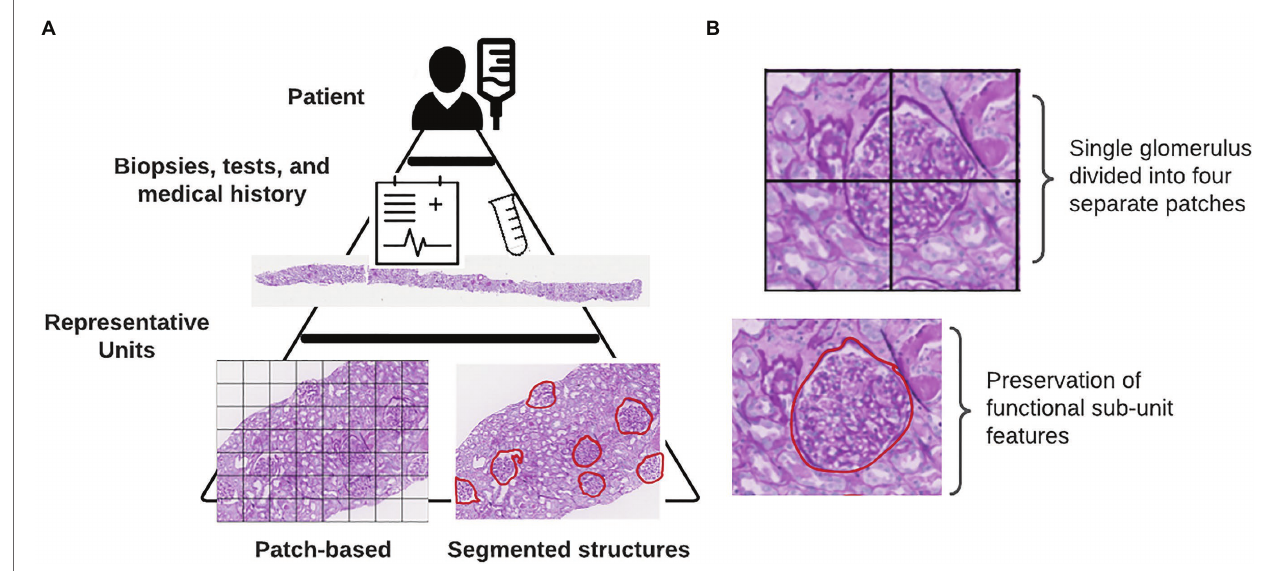
FIGURE 1 | Defining representative units. (A) Internal hierarchy of medical data. Each tier represents an increasing complexity or resolution of underlying biological units. At the base of this pyramid is shown the two different methods for defining representative units in a particular study. (B) Consequences of using a patch-based instance definition include the partitioning of functional sub-units across multiple